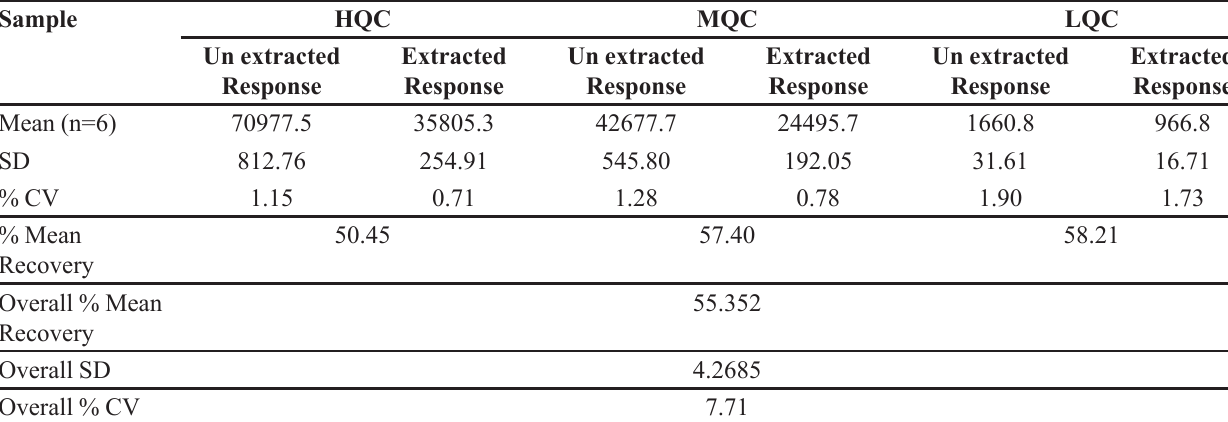
TABLE VIII - Recovery of analyte